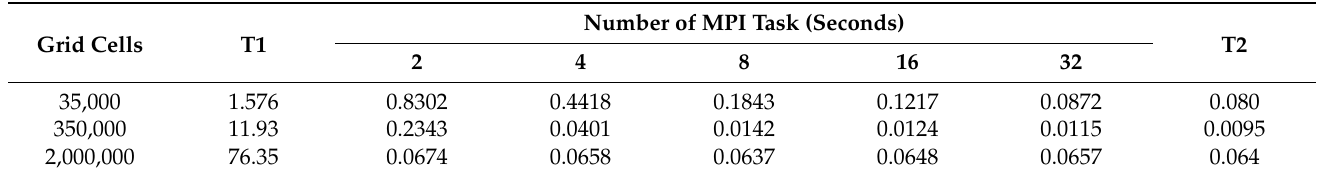
Table 3. Performance of the storage module code running with different numbers of MPI tasks. T1 represents the single storage time, and T2 is the ideal data forwarding time. The wall-clock consumption for point-to-point non-blocking communication is defined as the ideal data forwarding time, and MPI_Wtime() is used to compute